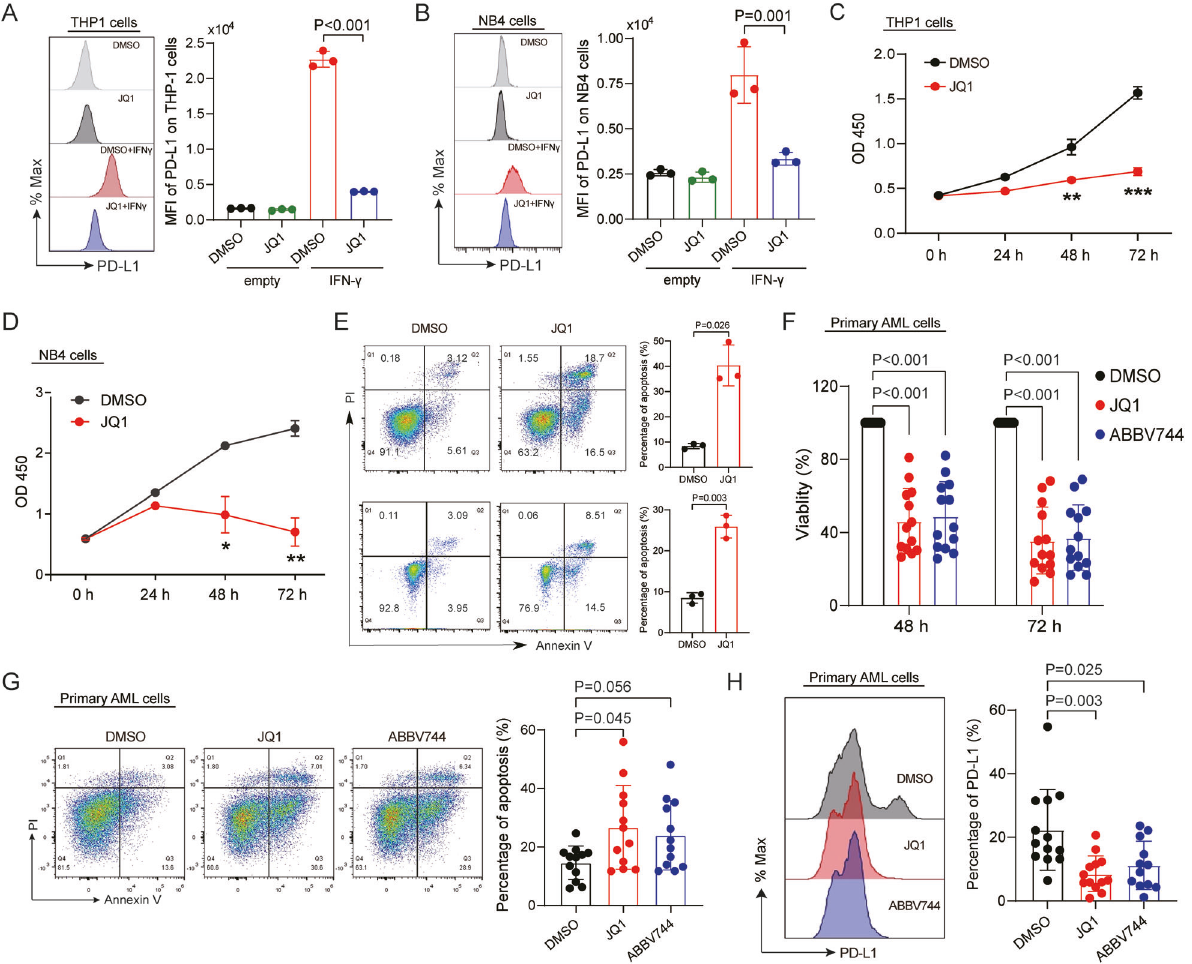
Fig. 6 BET inhibitor suppresses PD-L1 expression and cell growth and promotes cell apoptosis in AML. A THP1 cells were treated with 0.5 μ M JQ1 for 24 h in the absence and presence of 20 ng/ml IFN- γ , PD-L1 expression was determined by FACS ( n = 3). B NB4 cells were treated with 0.5 μ M JQ1 for 24 h in the absence and presence of 20 ng/ml IFN- γ , PD-L1 expression was determined by FACS ( n = 3). C THP1 cells were treated with 0.5 μ M JQ1 for 72 h, the proliferation assay was evaluated by CCK-8 assay at the indicated time point ( n = 3). D NB4 cells were treated with 0.5 μ M JQ1 for 72 h, the proliferation assay was evaluated by CCK-8 assay at the indicated time point ( n = 3). E THP1 cells (upper) and NB4 cells (lower) were treated with 0.5 μ M JQ1 for 24 h, and apoptosis was determined by FACS ( n = 3). F The CD3 − cells isolated from the bone marrow of newly diagnosed AML patients using human CD3 microbeads were administrated with 0.5 μ M JQ1 and 2 μ M ABBV-744 for 48 h, then the proliferation was assayed by CCK-8 experiment at the indicated time points ( n = 13 samples). G The apoptosis of CD3 − cells isolated from the bone marrow of newly diagnosed AML patients was detected by FACS ( n = 12 samples). H PD-L1 expression of CD3 − cells isolated from the bone marrow of newly diagnosed AML patients were detected by FACS ( n = 13 samples). Data were expressed as mean ± SD. n = 3 or more independent biological replicates, presented as individual points. P value < 0.05 was considered to be signi fi cant ( A – D , F – H : one-way ANOVA with Bonferroni post hoc test; E : two-tailed unpaired Student ’ s t